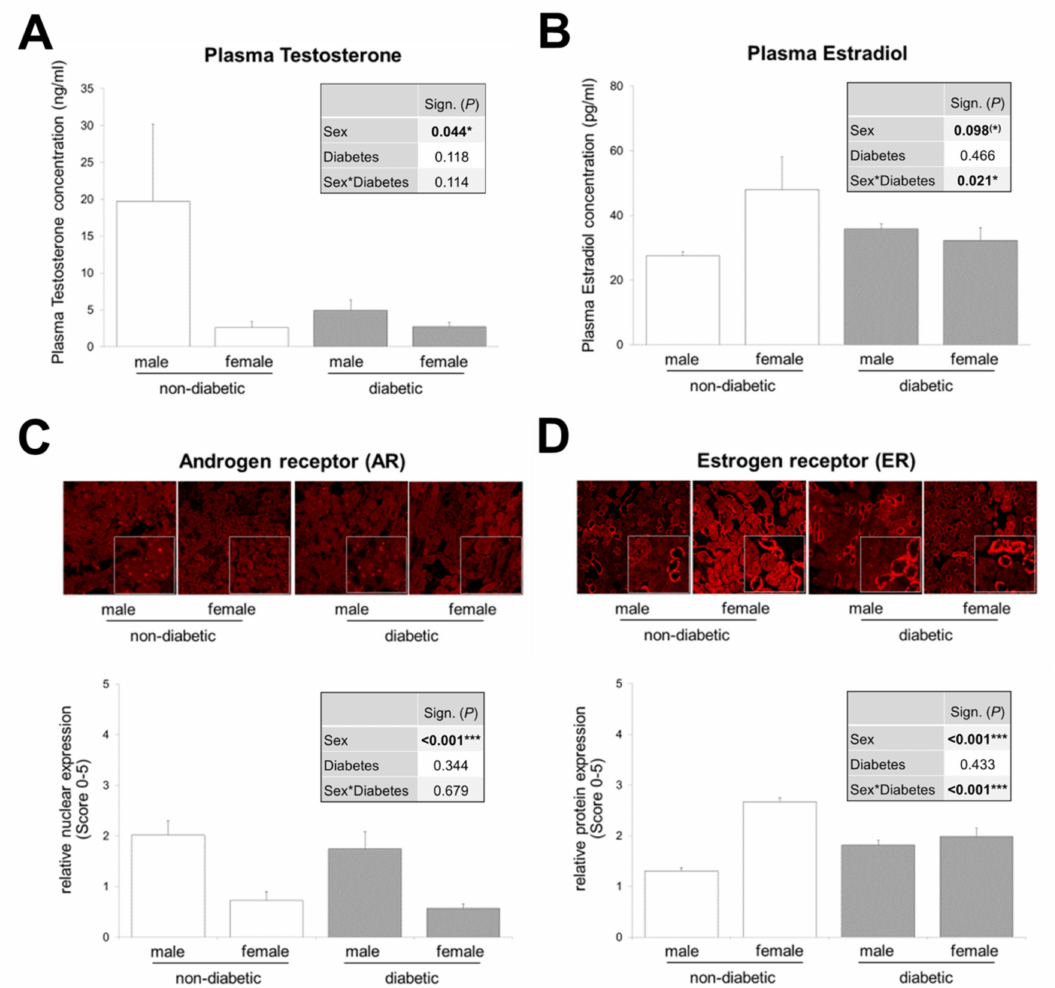
Figure 2. Sex hormone levels and expression of sex hormone receptors in both sexes of non-diabetic and diabetic mice. ( A ) Plasma testosterone ( n = 5 / 3 / 10 / 8). ( B ) Plasma estradiol ( n = 7 / 7 / 11 / 7). ( C ) Representative images of androgen receptor (AR) immunofluorescence and quantification of nuclear expression (graph) ( n = 10 / 7 / 8 / 5 animals with 10 non-overlapping kidney areas). ( D ) Representative images of estrogen receptor (ER) immunofluorescence and quantification of expression (graph) ( n = 8 / 7 / 9 / 6 animals with 10 non-overlapping kidney areas). ( A – D ) The significances, shown in the tables (graph inserts), were assessed using two-way ANOVA with sex (male or female) and diabetes (non-diabetic or diabetic) as the two factors. Sex, Diabetes: main e ff ect of sex / diabetes, respectively. Sex*Diabetes: interaction (determines whether the one main e ff ect depends on the level of the other main e ff ect). Magnification of immunofluorescence (200 × ). * P ≤ 0.05; *** P ≤